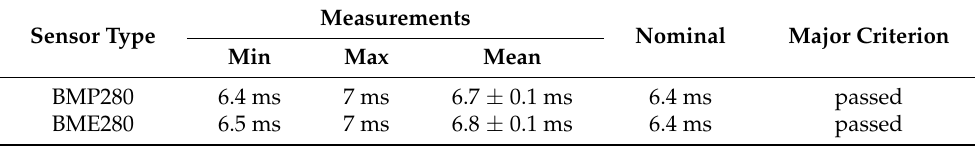
Table 7. Comparison of response time (in ms) of atmospheric pressure sensors.